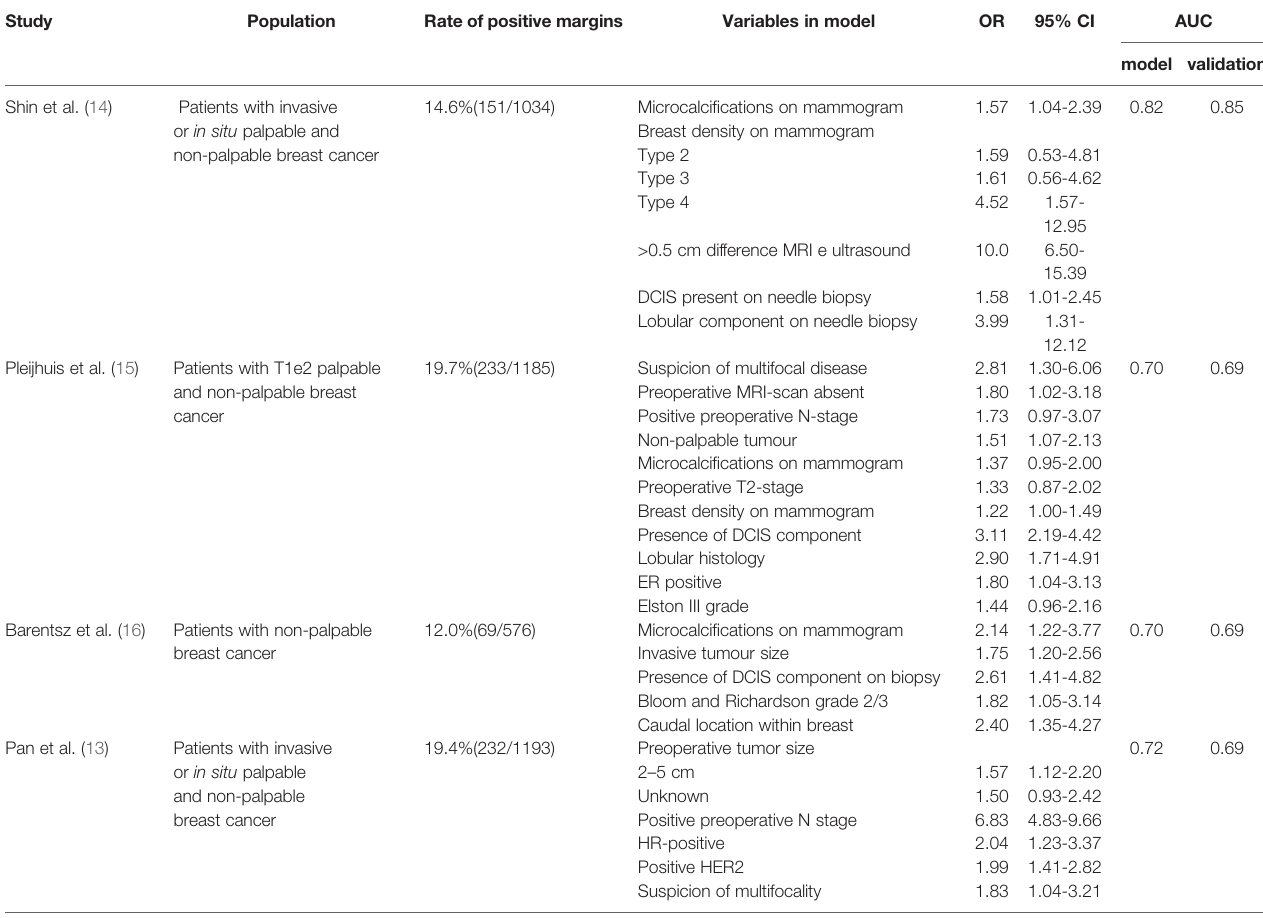
TABLE 4 | Comparison with previous model predicting likelihood of positive margin in BCS